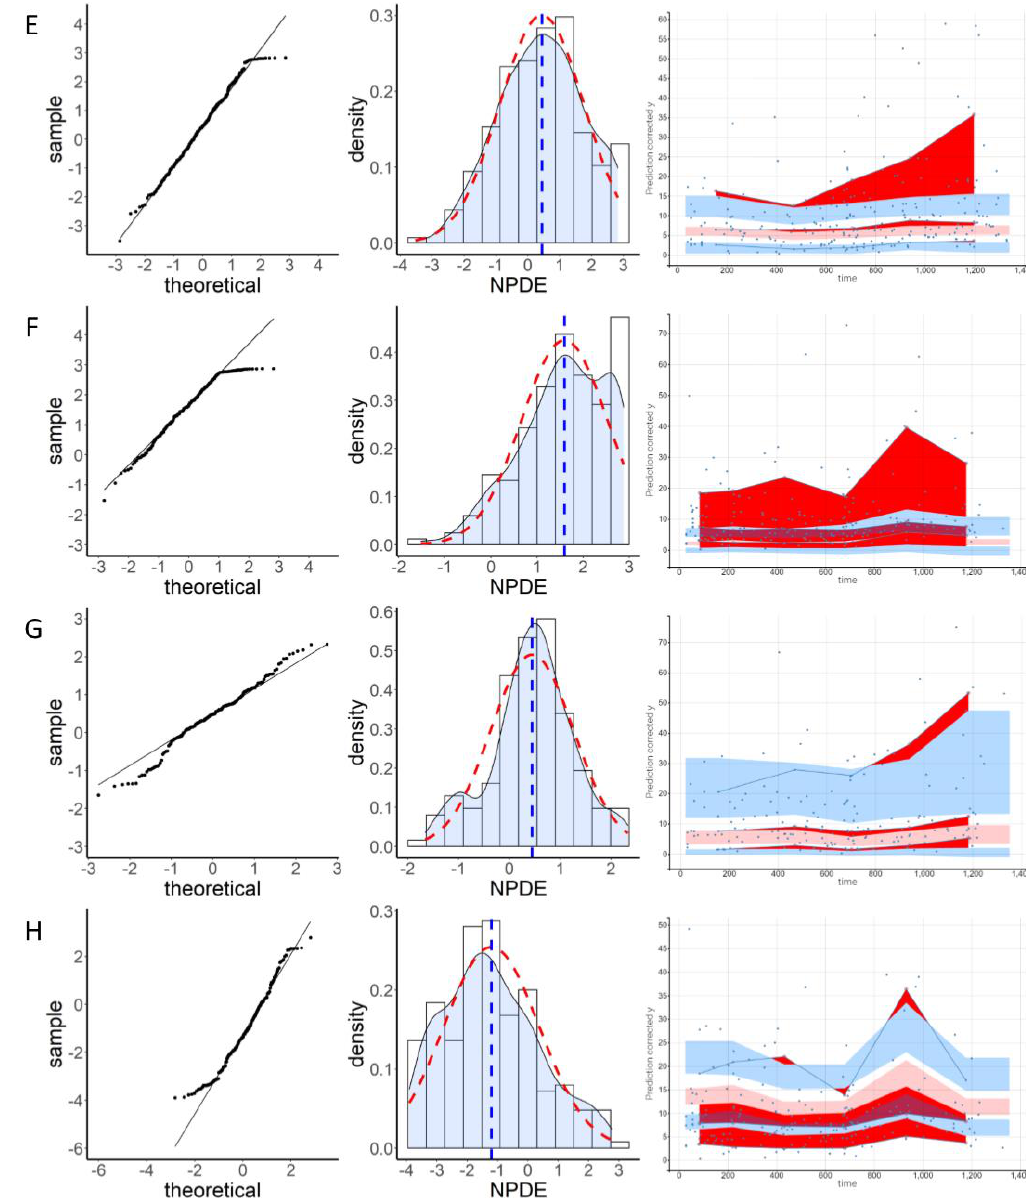
Figure 3. Distribution of NPDE and pcVPC for the 8 evaluated models ( A – H ). On the left, quantile-quantile graph of the NPDEs vs. theoretical normal distribution. In the middle, histogram and density of the NPDE distribution (blue dashed lines: mean; red dashed lines: density of the normal distribution). On the right, pcVPC (blue dots: observed concentrations; blue lines: 10th, 50th and 90th percentiles of observed concentrations; blue areas: prediction intervals of the 10th and 90th percentiles; light red area: prediction interval of the median; dark red area: outliers).